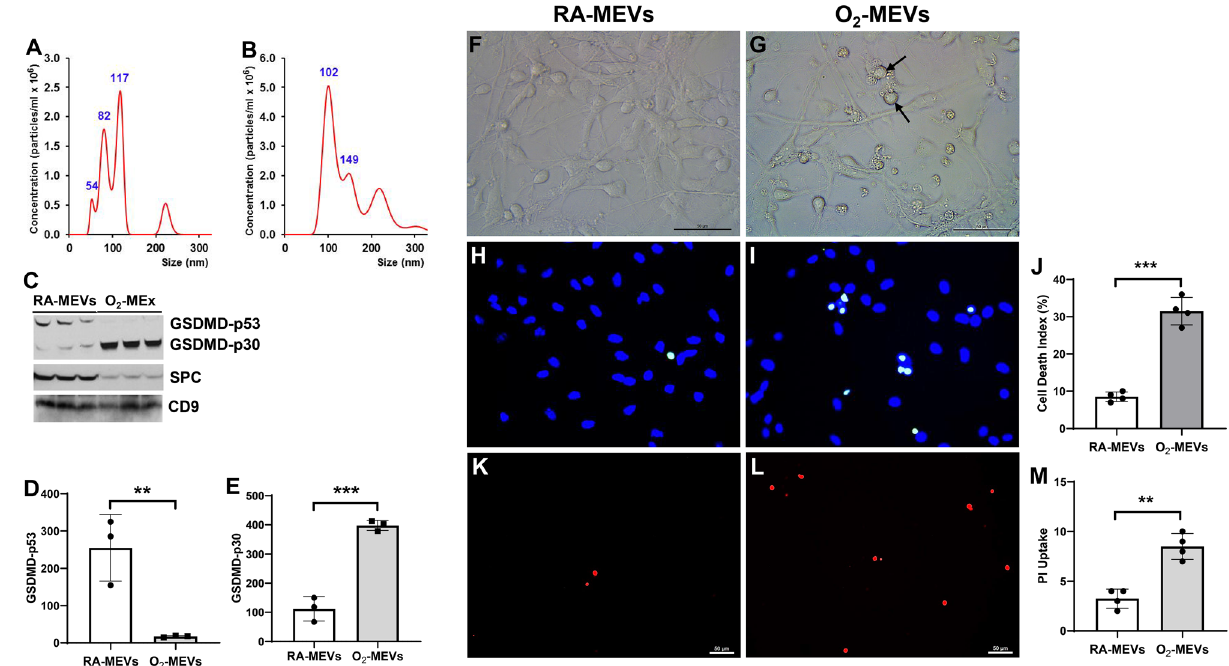
Figure 7. Hyperoxia stimulates MLE-12 cells to release EVs with an increased cargo of GSDMD-p30 that induce NSC death in vitro. MLE-12 cells were cultured under RA or 95% O 2 for 48 h. EVs in the culture media were isolated and analyzed by nanosight tracking, ( A ) EVs from RA-maintained MLE-12 cells (RA-MEVs) and ( B ) EVs from O 2 -exposed MLE-12 cells (O 2 -MEVs). ( C ) Representative western blots of GSDMD, SPC and CD9 (Supplemental Fig. 7C). O 2 -MEVs had decreased GSDMD-p53 cargos (( D ), ** P < 0.01) and increased GSDMD-p30 cargos (( E ), *** P < 0.001) compared to RA- MEVs. n = 3/group. NSC were cultured in the presence of RA-MEVs ( F , H , K ) or O 2 -MEVs ( G , I , L ) for 48 h. ( F ) and ( G ): live cell imaging under phase contrast showed blebbed cells (black arrow) in O 2 -MEVs treatment. ( H ) and ( I ): TUNEL (green signals) and DAPI nuclear staining (blue signals) showed increased cell death in O 2 -MEVs treated NSC compared to RA-MEVs treated NSC (( J ) n = 4/group, *** P < 0.001). ( K ) and ( L ): PI uptake (red signals) demonstrated increased pyroptotic cell death with